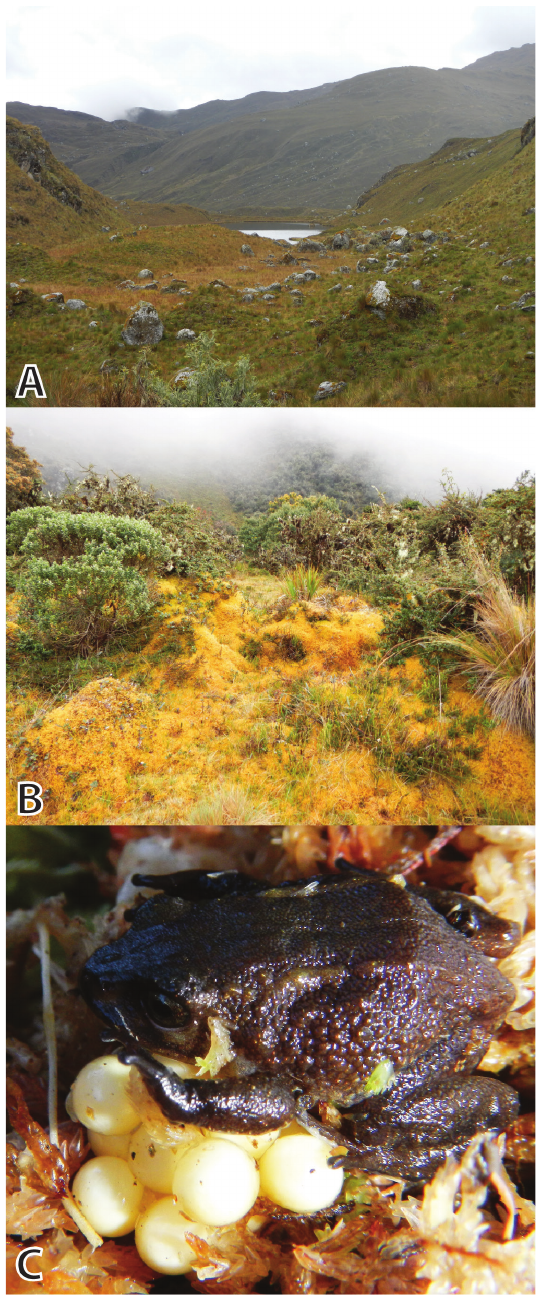
Figure 8. Habitats of Pristimantis attenboroughi sp. n. in the PPPF: A type locality in the upper Tarhuish valley at Laguna Udrecocha, Puna at 3936 m a.s.l., 17 May 2012 B upper montane forest at 3550 m a.s.l. where P. attenboroughi sp. n. was found in moss pads C female P. attenboroughi sp. n. (MUSM 31980, SVL 21.5 mm) guarding a clutch in a moss pad. Photos by E.